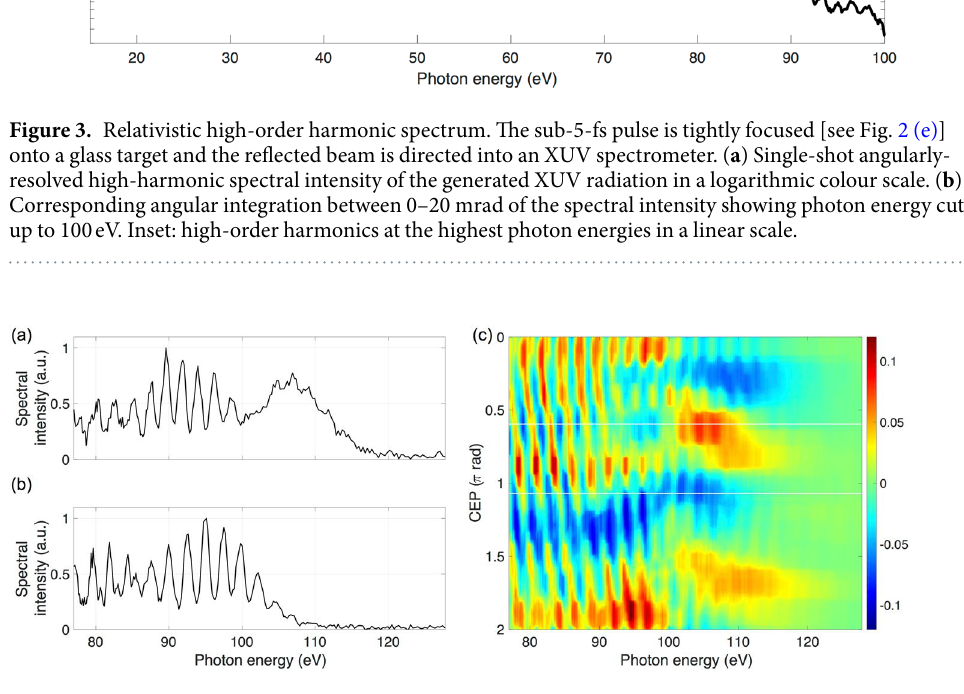
distinctly different patterns: (a) an almost 20-eV-broad continuum around 100 eV photon energy and a larger cutoff, or (b) a modulated shape and lower cutoff. These are significant indications of the expected electric field dependence of the process, which additionally confirm the short driving pulse duration.